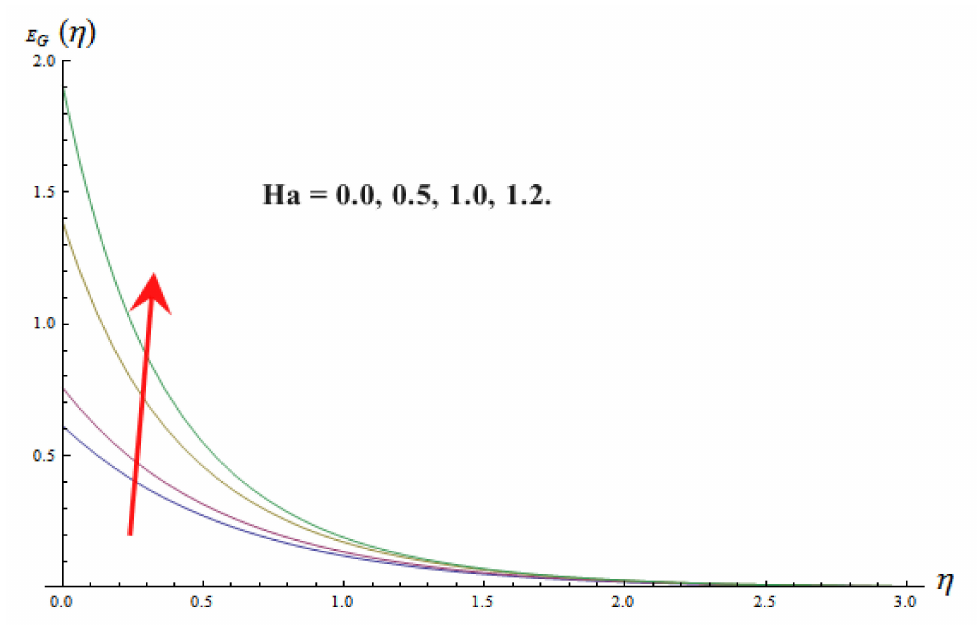
Figure 12. Impact of Ha on E G ( η ) keeping Γ = 0.5, Pr = 2, Br = 2, λ = 2, Ec = 0.2, Rd = 2, β 1 = 0.2, λ 1 = 0.2, K ∗ =